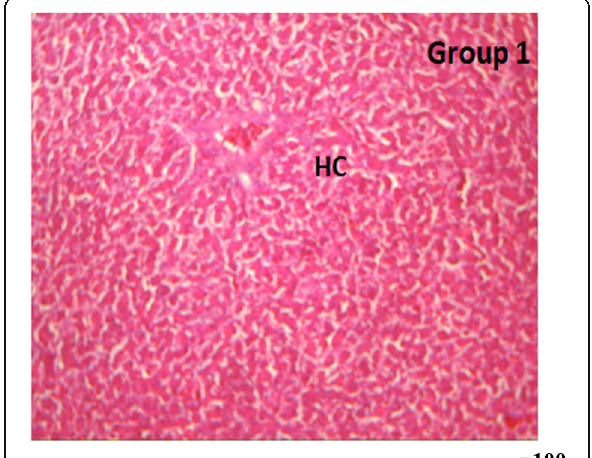
Fig. 1 Photomicrographs of the liver obtained from a bird in the control group. HC, hepatic cells